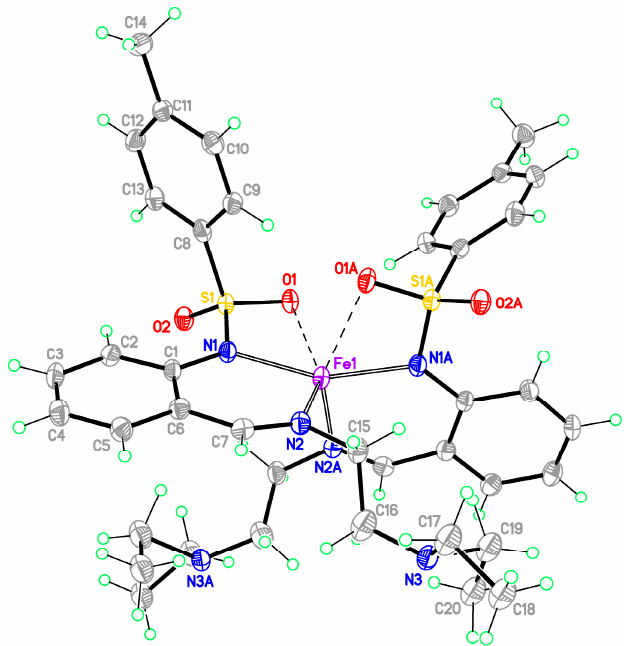
Figure 2. Molecular structure of 1-Fe . Only one orientation of the disordered diethylaminoethyl substituents is presented for clarity. Displacement ellipsoids are shown at the 50% probability level. The label A denotes symmetrically equivalent atoms generated by the two-fold axis. Dashed lines indicate secondary Fe ··· O interactions. Selected bond lengths and angles (Å and ◦ ): Fe1–N1 2.070(2),